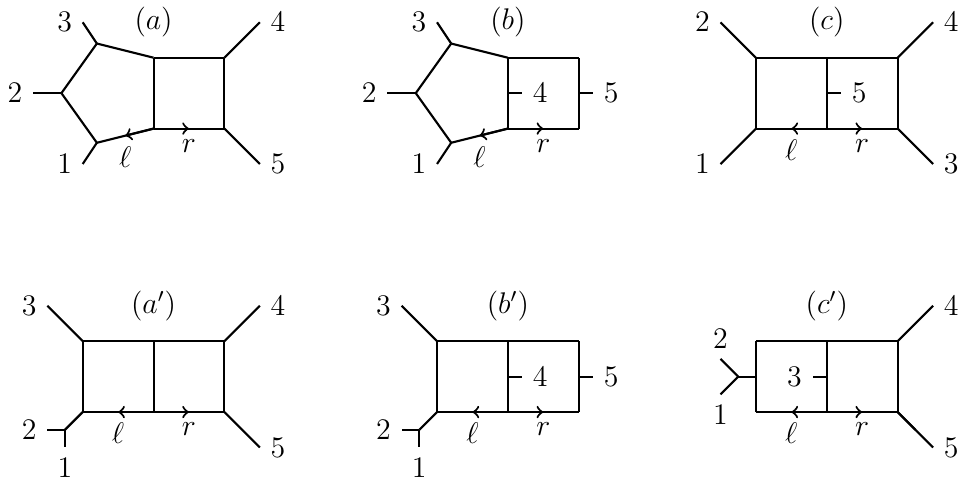
Figure 1 . The six graphs contributing to two-loop (cid:12)ve-point amplitudes in maximally super- symmetric Yang-Mills and supergravity [67]. The reducible diagrams a 0 ; b 0 ; c 0 were denoted d; e; f respectively in [48].